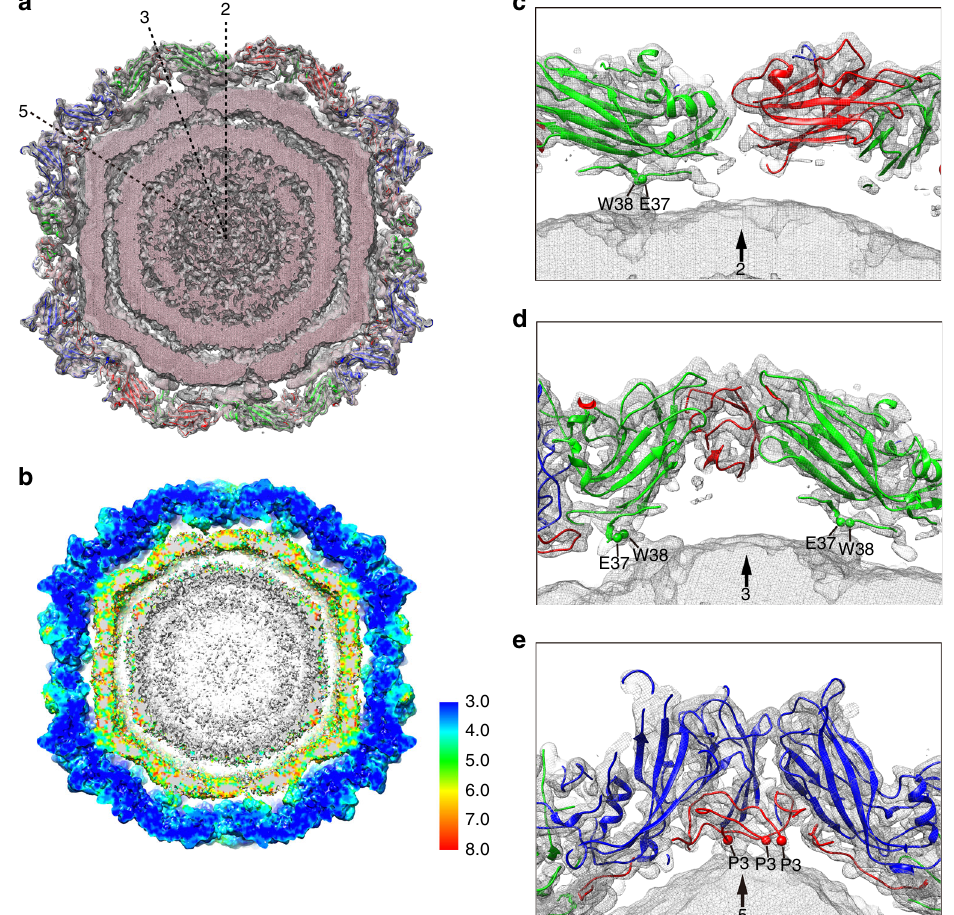
Fig. 4 Capsid-RNA interactions in the CVA6 A-particle. a Central slab (25 Å thickness) of the CVA6 A-particle density map ( light pink meshed density) and corresponding atomic model (ribbon diagrams) viewed along an icosahedral 2-fold axis. Capsid-RNA interactions can be seen beneath the VP2 and VP3 subunits near the 5-fold axis. 2-, 3- and 5-fold icosahedral symmetry axes are labeled with dashed lines. b The details of local resolutions related to capsid-RNA interactions. c – e Close-up views at the capsid-RNA interface are shown for regions near the 2-fold c , 3-fold d and 5-fold e axes. The N-termini of all VP2 subunits contact the genome in disordered regions of the density map, which precluded building an atomic model. Therefore, only the nearest (close to interaction interface) and identi fi able residues are labeled ( spheres ). Strong, continuous densities are observed between VP3 and the RNA genome at the 5-fold axes e . Contacts are mediated by residue P3 ( red spheres ) at the N-termini of